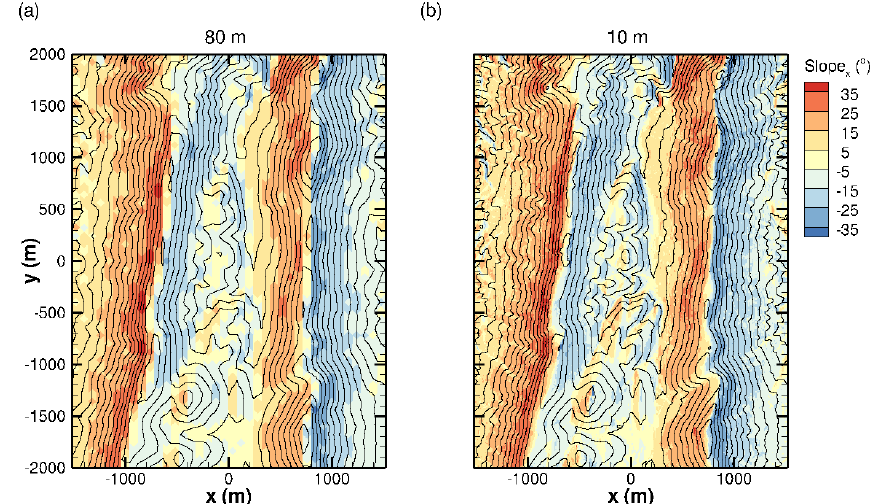
Figure 9. Slope in x (SW–NE, 225 ◦ ) direction with different resolutions mapped on the AOI’s surface (ALS terrain data): (a) 80m mesh, (b) 10m